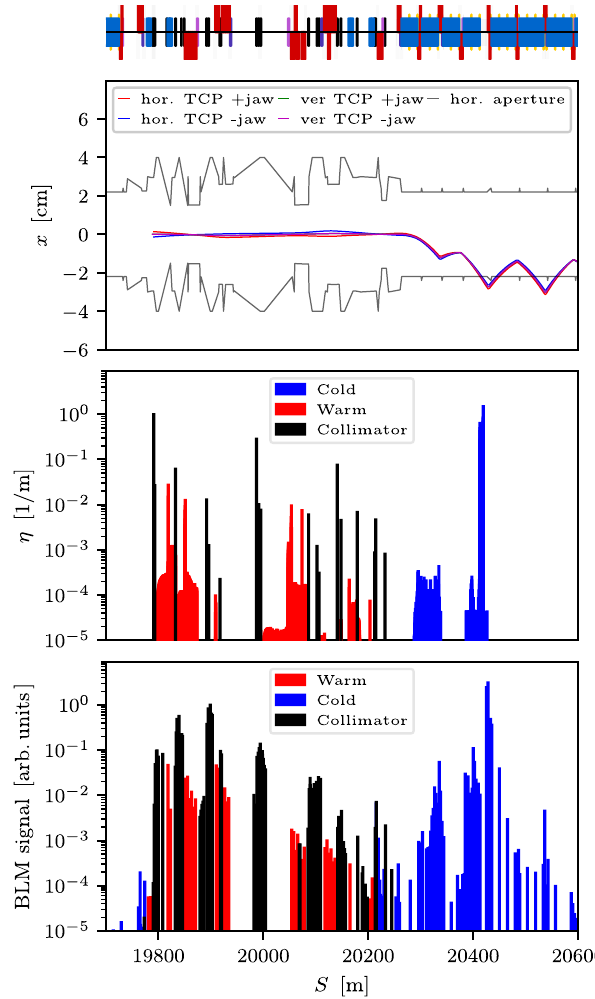
FIG. 4. The top plot shows trajectories of fully stripped off- rigidity 208 Pb 82 þ ions escaping the B1 TCPs, as calculated with MAD-X. The 4 trajectories depicted correspond to starting positions at both jaws of the horizontal and vertical TCPs. The middle plot shows the loss pattern simulated for PSI beams using the S ix T rack – FLUKA simulations. The bottom plot shows the measured B1H loss map with 208 Pb 81 þ beams at top